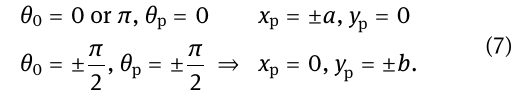
Table 5: k of analytical solutions of fi ve cracked